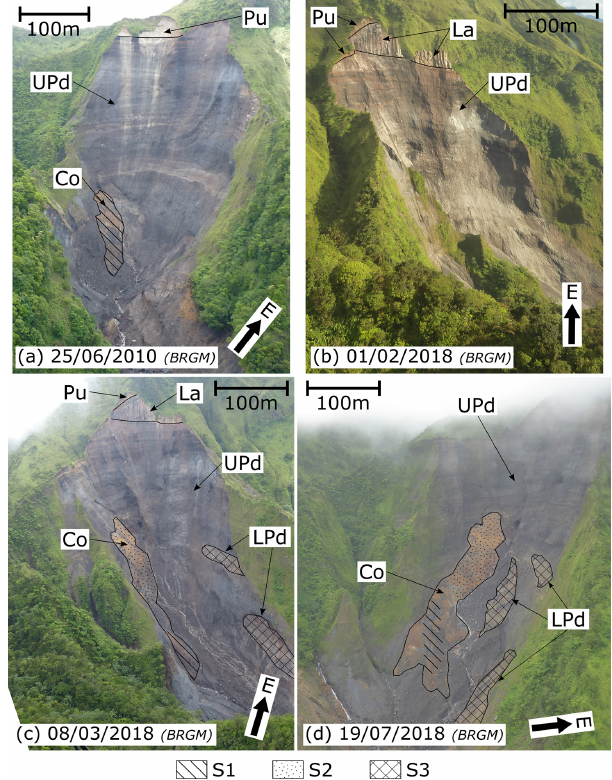
Figure 5. Aerial photographs of the Samperre cliff on (a) 25 June 2010, (b) 2 January 2018, (c) 8 March 2018 and (d) 2 July 2018. The east direction is given by the arrow, the scale is given for the cliff rim. Outcrops of visible geological units are highlighted. Raw pictures (along with additional pictures) are given in the